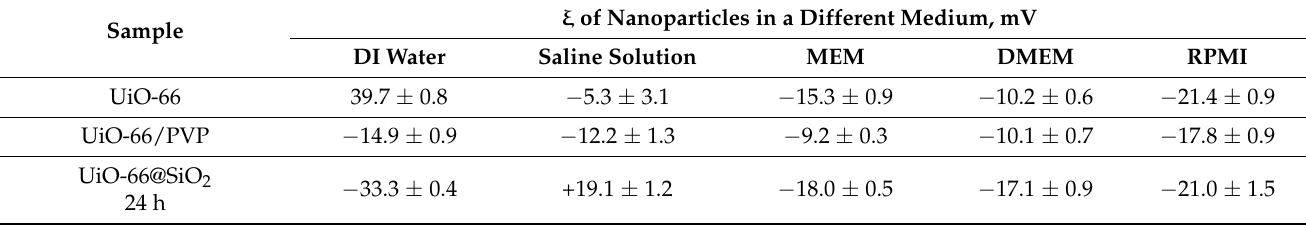
Table 2. Zeta potential of UiO-66, PVP-grafted UiO-66, and core–shell UiO-66@SiO 2 in model media. ξ of Nanoparticles in a Different Medium, mV Sample DI Water Saline Solution MEM DMEM RPMI UiO-66 39.7 ± 0.8 UiO-66/PVP − 14.9 ±